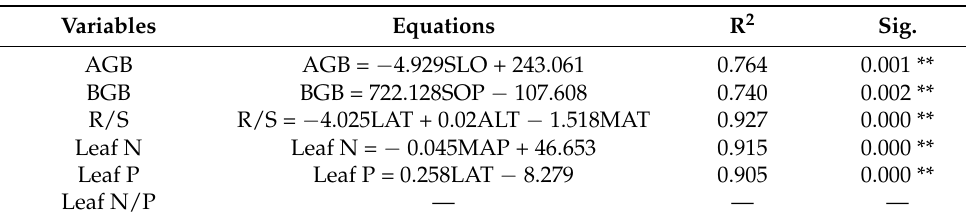
Table 1. Stepwise regression analysis (SRA) used to identify the key factors of plant biomass and leaf N and P stoichiometry.